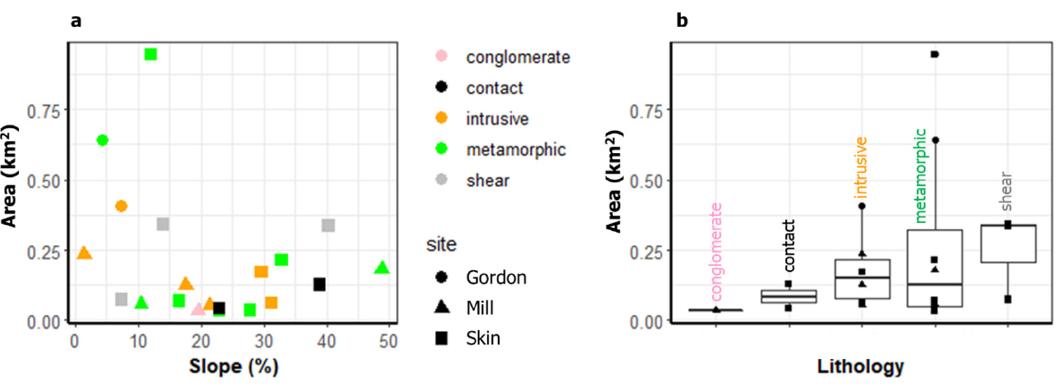
Figure 8. Relationships between ( a ) the drainage area and local slope at the flow heads colored according to the lithology and ( b ) a comparison of the drainage areas in terms of the lithology. For the lithologies, “contact” indicates the flow head was on the boundary between two lithologies, and “shear” indicates that the flow head was in a shear zone. In ( b ), the box plots are represented as described in Figure 5, except the points are shown for all flow heads.